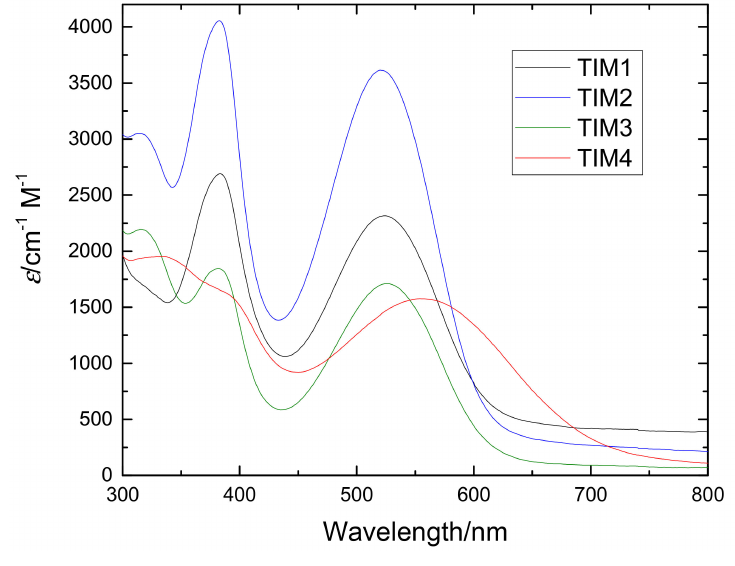
Figure 3. UV–visible absorption of the TIM series in EtOH at 5 × 10 − 5 mol mL − 1 . Table 1. The absorption peaks ( λ max ) and their corresponding molar absorption coe ffi cients ( ε ) of the TIM series.